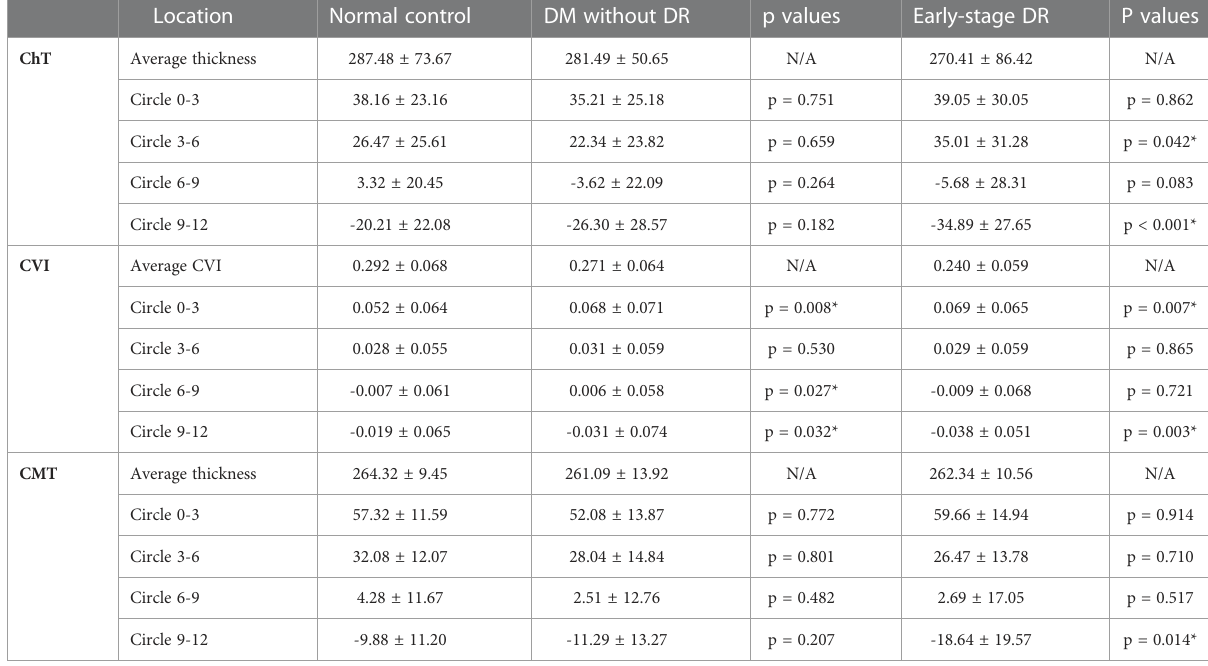
Values werecalculated as Circle x-y - average values andshown as means ±SDs (). DM, diabetes mellitus; DR, diabetic retinopathy; ChT, Choroidalthickness; CVI, Choroidal Vascularity Index; CMT, central macular thickness. Statistical differences were analyzed between the groups of patients with DM and the normal control, p < 0.05 indicates a statistically signi fi cant difference, annotated with *. NA, not applicable.